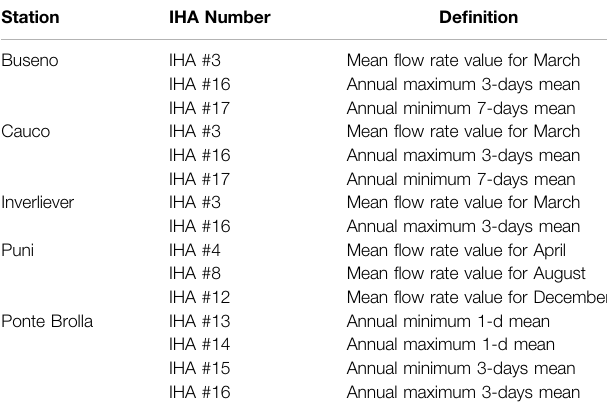
TABLE 4 | Indicators of Hydrologic Alteration showing the highest